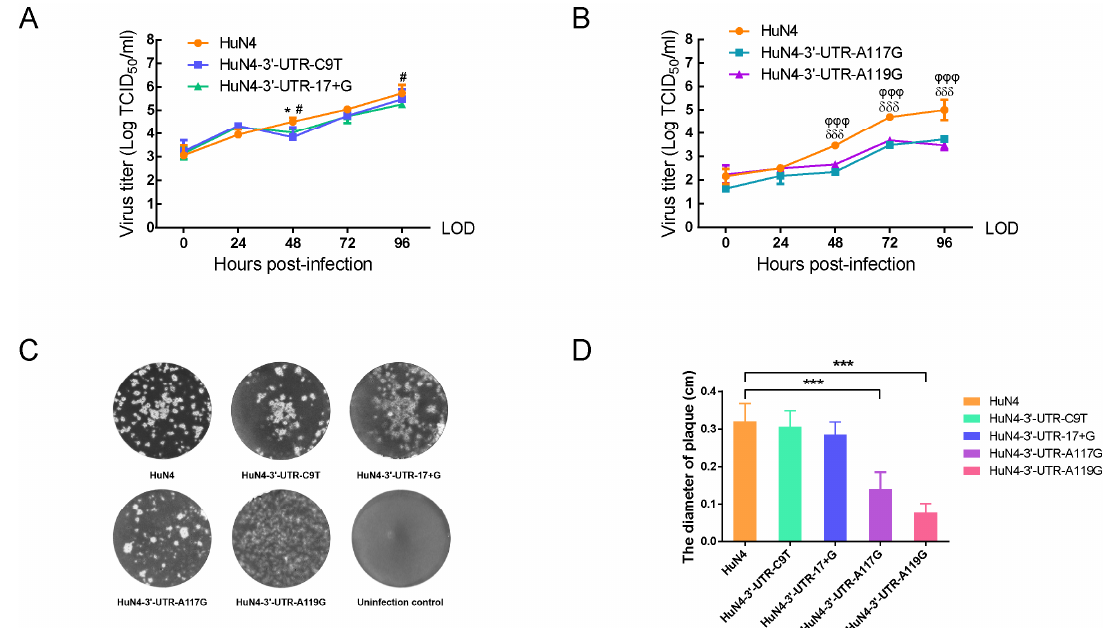
Figure 4. Comparison of replication efficiency of parental and mutant viruses. ( A ) The growth kinetics of parental HuN4 and mutant viruses (HuN4-3 ′ -UTR-C9T and HuN4-3 ′ -UTR-17+G). LOD: limit of detection. Asterisk (*) indicates a significant difference between HuN4 and HuN4-3 ′ -UTR-C9T. ( * , p < 0.05). Pound (#) indicates a significant difference between HuN4 and HuN4-3 ′ -UTR-17+G ( # , p < 0.05). ( B ) The growth kinetics of parental HuN4 and mutant viruses (HuN4-3 ′ -UTR-A117G and HuN4-3 ′ -UTR-A119G). LOD: limit of detection. Delta ( δ ) indicates a significant difference between HuN4 and HuN4-3 ′ -UTR-A117G ( δδδ , p < 0.001). Phi ( φ ) indicates a significant difference between HuN4 and HuN4-3 ′ -UTR-A119G ( φφφ , p < 0.001). ( C ) Plaque morphology of the parental PRRSV HuN4 and mutant viruses in Marc-145 cells. ( D ) The diameters of viral plaques were measured and analyzed. Asterisk (*) indicates a significant difference between HuN4 and its mutant viruses (***, p < 0.001).